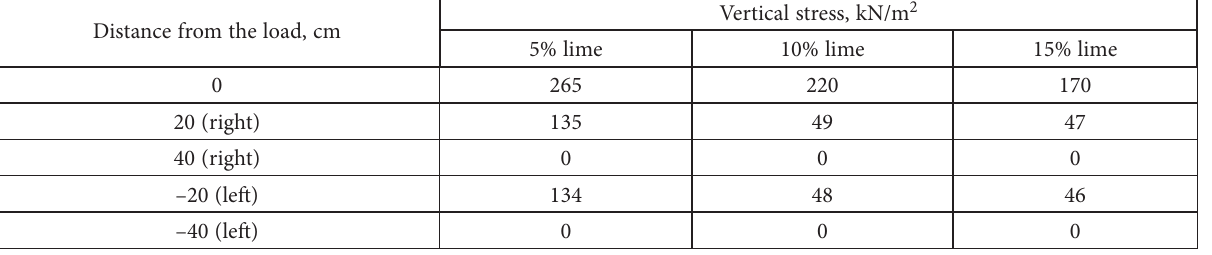
Distance from the load, cm